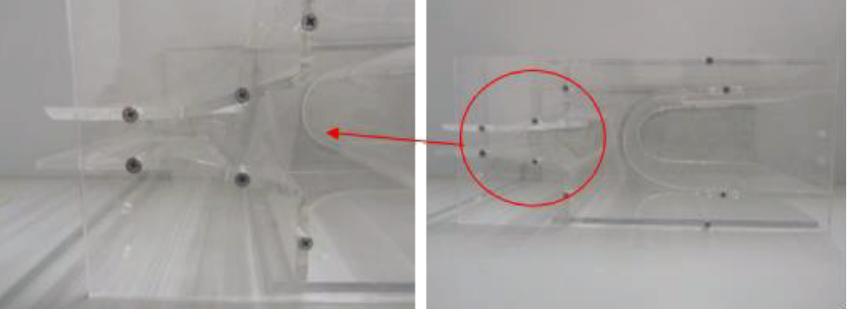
Figure 10: Test region of dump di ff user.